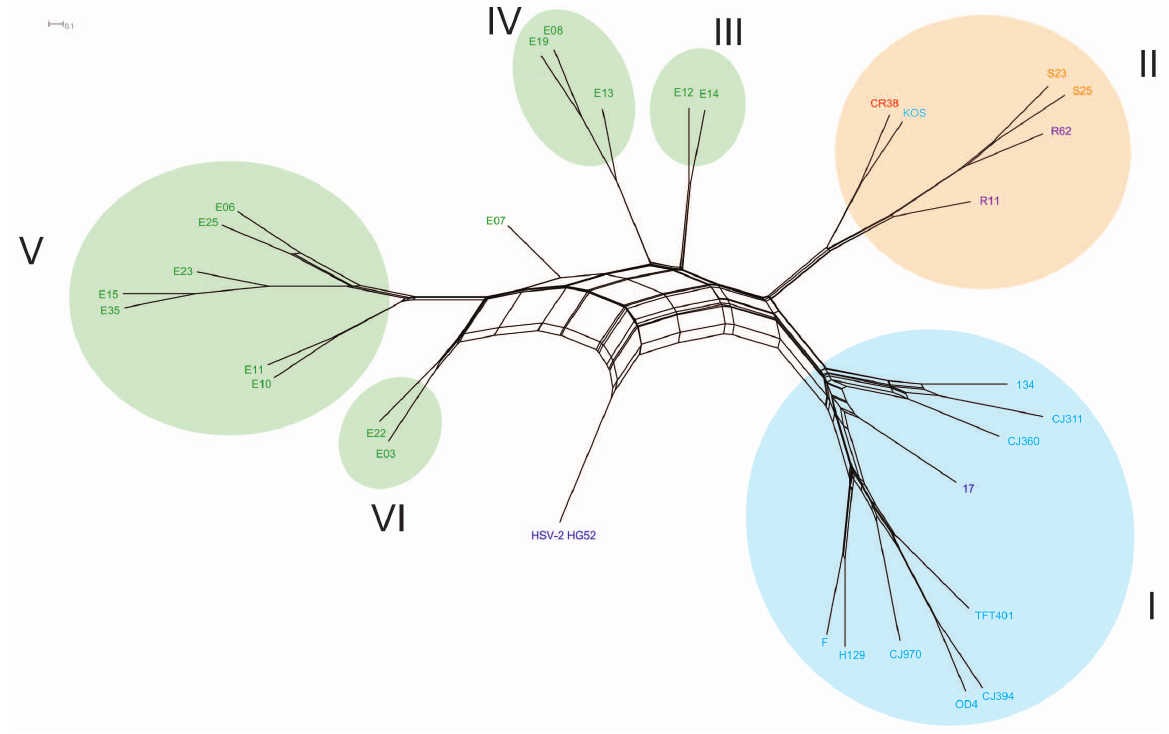
Figure 2. Phylogenetic network generated from 500, maximum likelihood bootstrap replicates. The HSV-1 strains in the network form the same six clades as in Figure 1. Clade I includes European/North American strains, Clade II comprises East Asian strains and III, IV, V and VI are East African. HSV-2 was used as an outgroup. Splitstree 4 was used to generate the network. The viral isolates are colored according to country of origin and are as follows: U.S.A: light blue, U.K.: dark blue, China: red, South Korea: purple, Japan: orange, and Kenya: